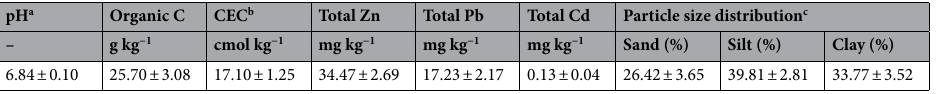
Table 1. Physicochemical properties of the collected soil. Data were means ± standard deviations of triplicate experiments. a 1:2.5 soil/water ratio. b Cation exchange capacity. c Sand (2–0.02 mm), Silt (0.02–0.002 mm), and Clay (≤ 0.002